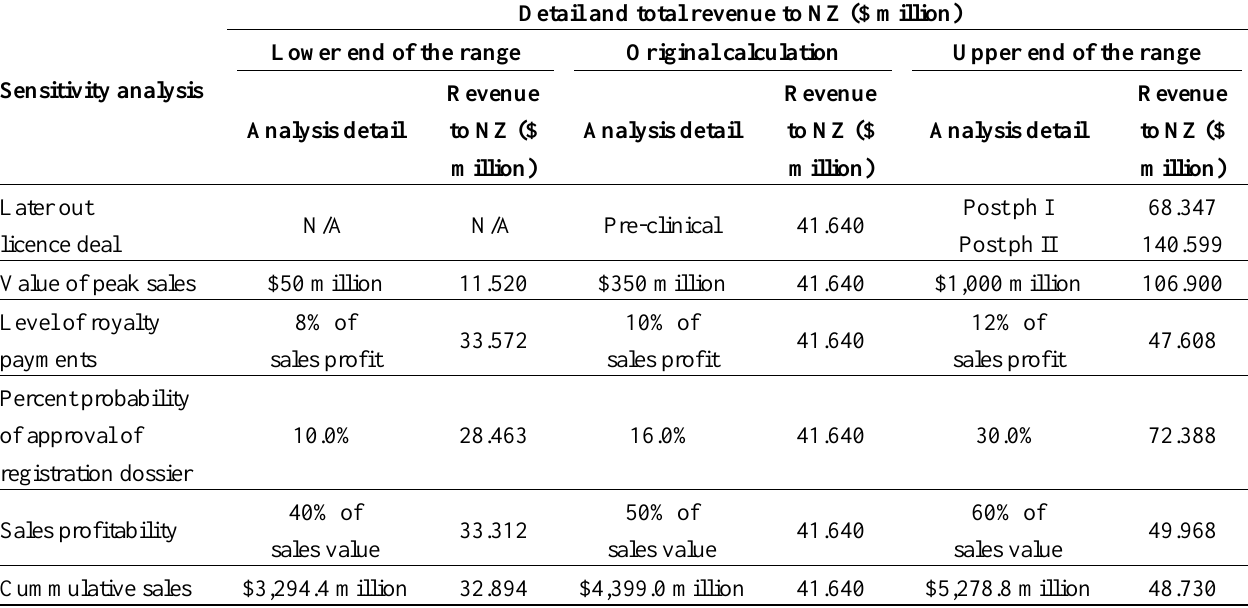
Table 3. Summary of sensitivity